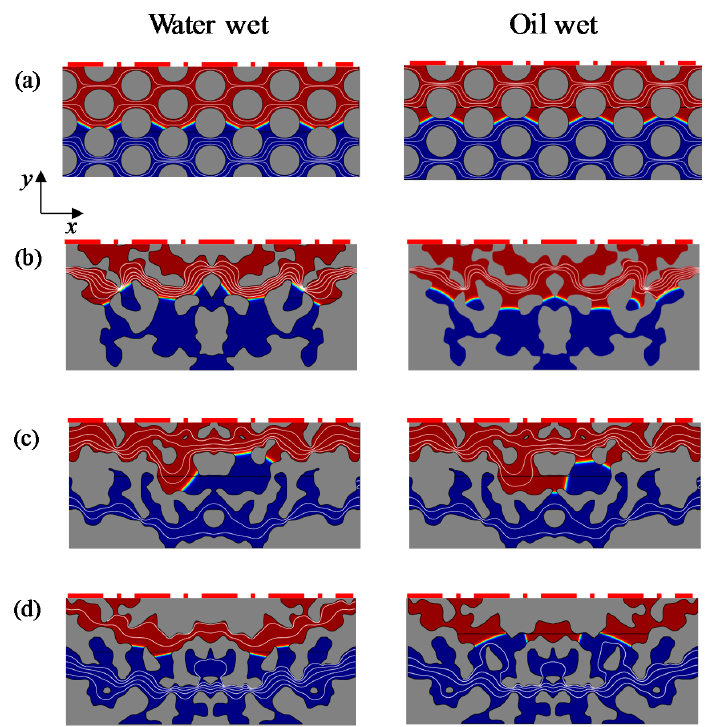
Figure 5. Distribution of the two phases (oil, in red; water, in blue) at steady state with θ = 90° for ( a ) HDa and S o = 0.42, ( b ) E1 and S o = 0.49, ( c ) E4 and S o = 0.50, and ( d ) E8 and S o = 0.49. Streamlines of the flow field are plotted as white curves.